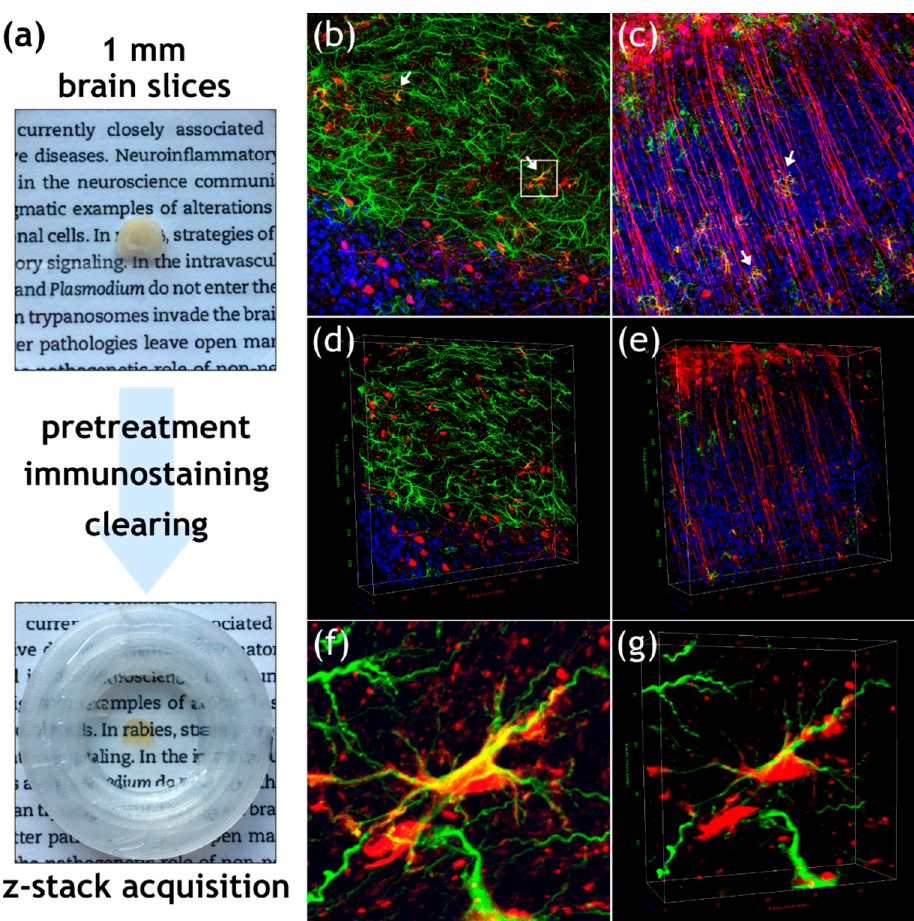
Figure 2. 3D immunofluorescence imaging of field RABV-infected neurons and astrocytes in a mouse brain. ( a ) Workflow for 3D immunofluorescence imaging, including vibratome sectioning into 1 mm slices, pretreatment, immunostaining, and subsequent optical clearing with organic solvents. Confocal imaging and acquisition of cleared tissue slices was done in custom-made imaging containers (see lower image). ( b , c ) Maximum z- and ( d – e ) 3D projections of z-stack (x, y, z = 400 µ m, 400 µ m, 59 µ m for D and 400 µ m, 400 µ m, 103 µ m for E) after indirect immunofluorescence for RABV phosphoprotein P (red), GFAP (green), and NeuN (blue). White arrows in Figure 2b indicate RABV P and GFAP-positive astrocytes. ( f ) Maximum projection of detail from Figure 2b (see white box) with GFAP-positive cell (green) and associated RABV P fluorescence (red). ( g ) 3D projection of detail view from Figure 2f.